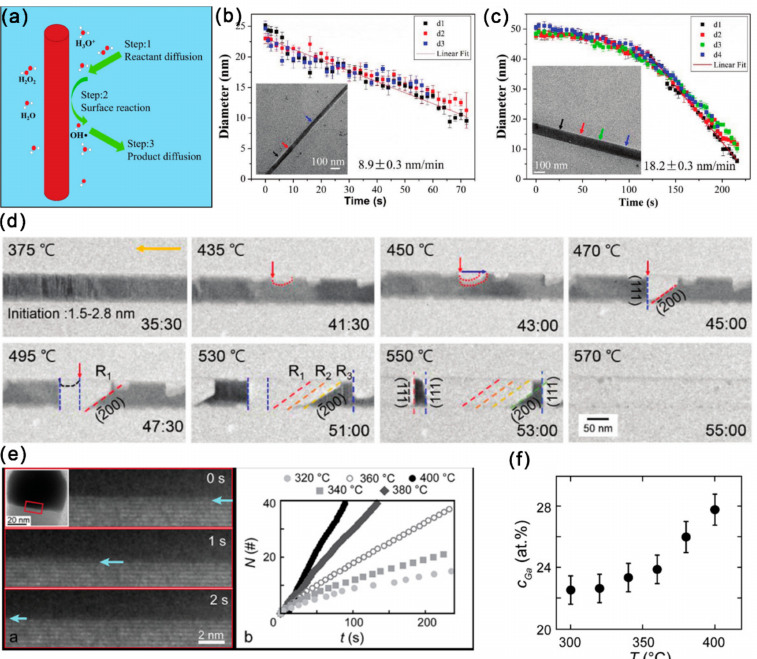
Figure 7. ( a ) Schematic diagram presenting the dissolution procedure of InAs NWs in the radiolytic water. The diameter of ( b ) an MBE-grown and ( c ) a MOCVD-grown InAs NWs vs. irradiation time. Reproduced with permission [13]. Copyright 2018, The Royal Society of Chemistry. ( d ) A series of TEM images captured during the in situ heating process. Reproduced with permission [76]. Copyright 2019, The Royal Society of Chemistry. ( e ) TEM image series showing the layer-by-layer removal of GaAs at the droplet/NW interface. The extracted cumulative number of bilayers (N) removed is also presented as a function of time (t). ( f ) Ga content of the droplet particle as a function of temperature, presenting a monotonic increase of Ga with temperature. Reproduced with permission [77]. Copyright 2019, American Chemical